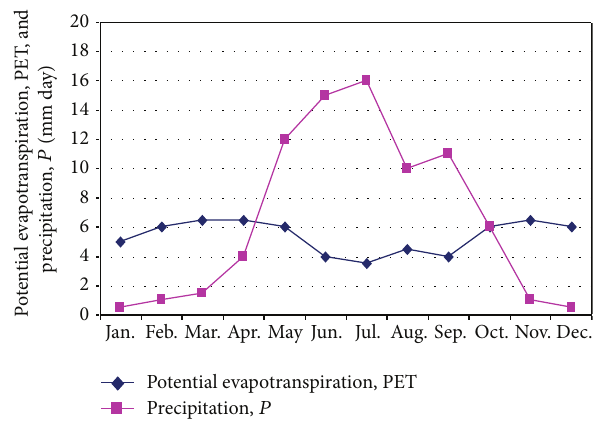
Figure 1: Hydrological balance of PET and precipitation at Mymensingh [28].